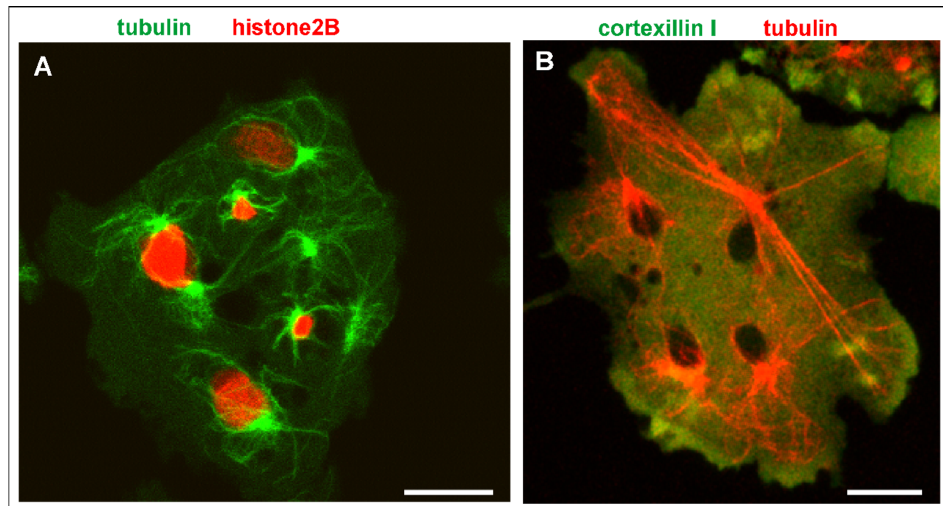
Figure 7. Multinucleate cells in interphase. ( A ), heterogeneity of nuclear sizes in a RacB-null cell. This cell expressed mRFP-histone2B (red) to label the nuclei, and GFP- α -tubulin (green) to visualize nuclear-bound and free centrosomes with their cytoplasmic microtubule systems in the interphase stage. ( B ), a Septase-null cell with extremely long microtubules that